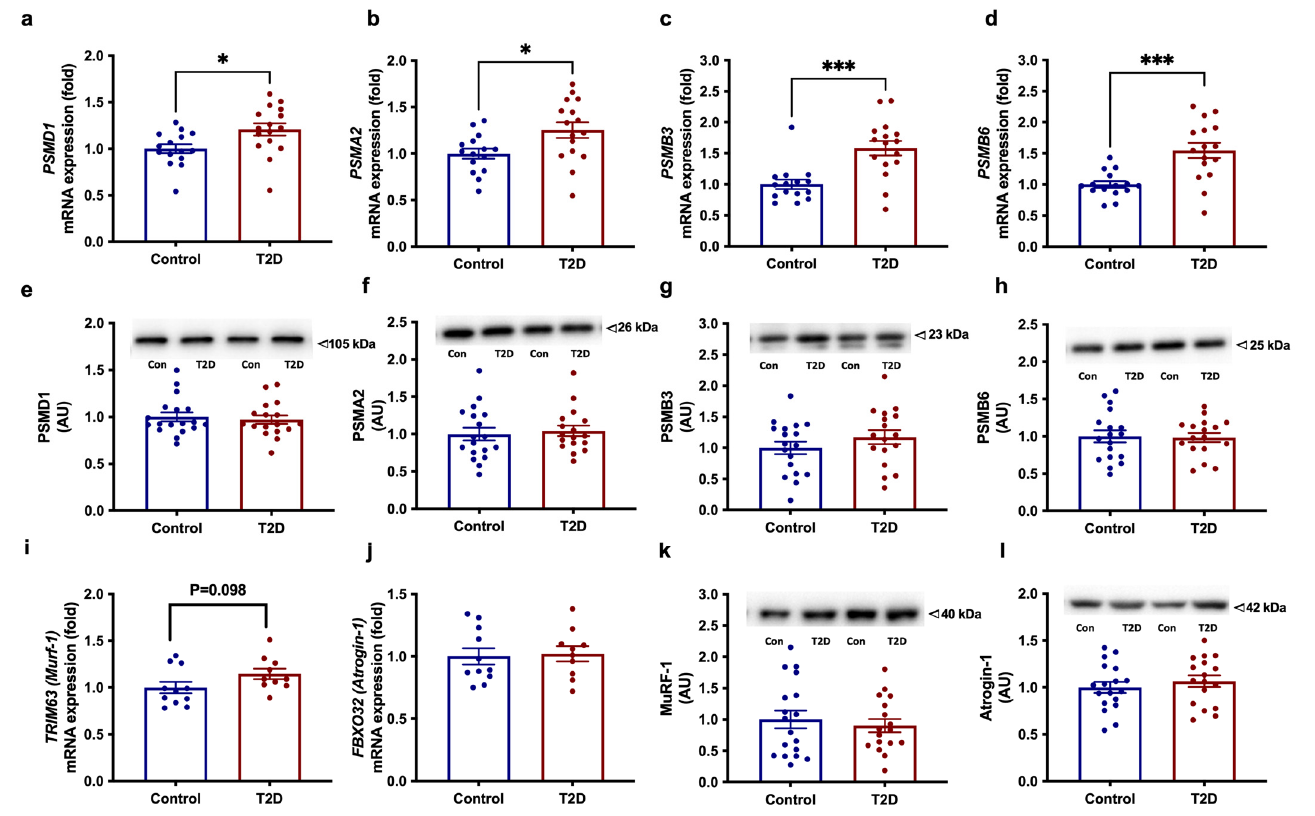
Figure 2. mRNA expression and protein abundances of genes involved in proteasomal degradation; ( a – h ) the proteasomal subunits PSMA2, PSMB3, PSMB6, and PSMD and ( i – l ) the muscle-specific E3 ubiquitin ligases TRIM63 (encoding MuRF-1) and FBXO32 (encoding Atrogin-1) in skeletal muscle of patients with T2D ( n =10–17) vs. obese controls ( n = 10–19). Data are means ± SEM. * p < 0.05 and *** p < 0.001 vs. obese controls.